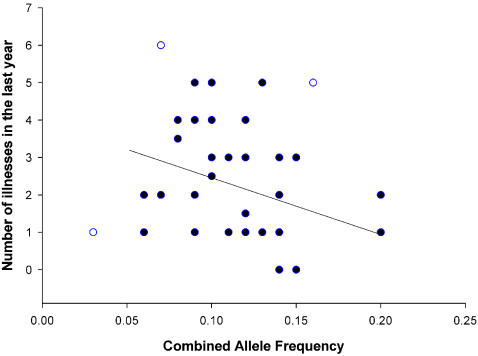
The relationship between combined allele frequency and the number of self reported illnesses in the previous year.Outliers are indicated as open circles.